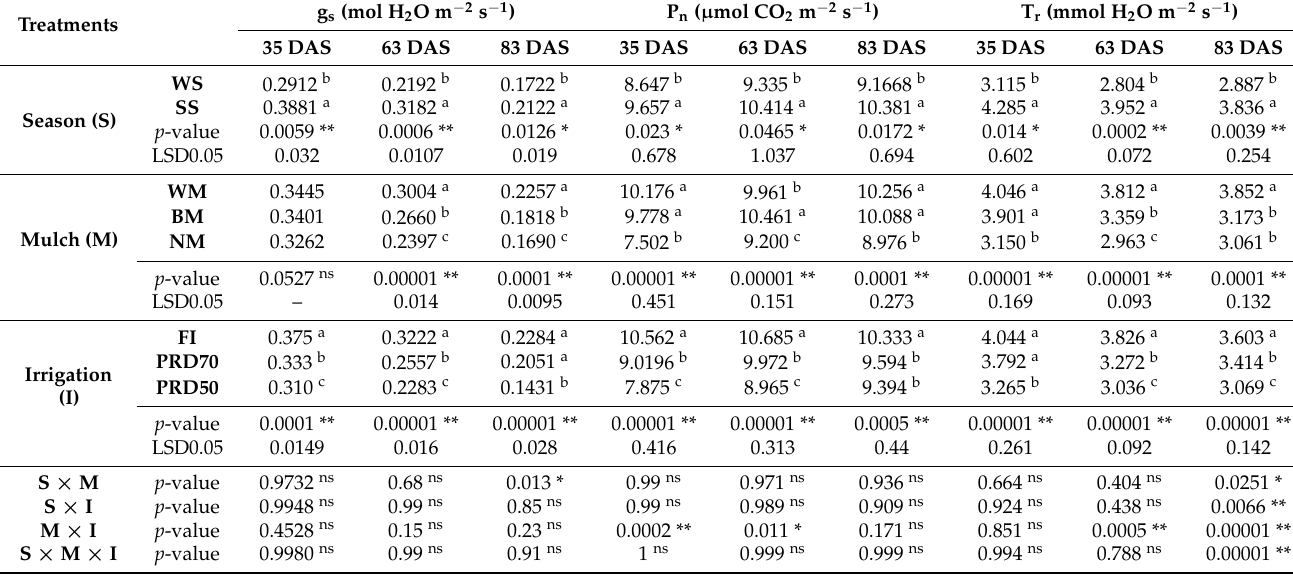
Table 2. Analysis of variance of stomatal conductance (g s ), photosynthesis (P n ), and transpiration (T r ) at the development stage (35 DAS), mid stage (63 DAS), and late stage (83 DAS) of squash growth during the winter (WS) and spring (SS) growing seasons.